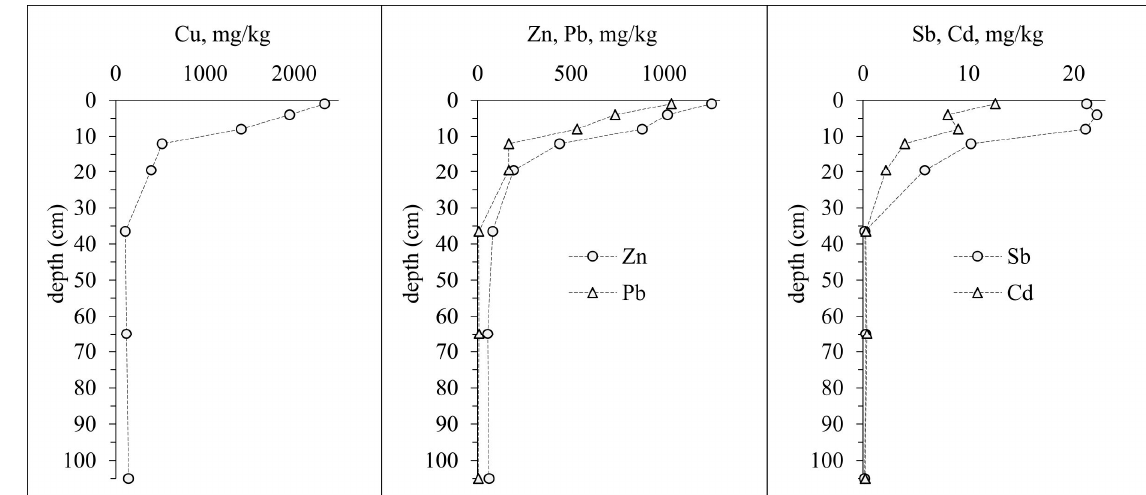
Figure 2. The view of Karabashskiy Copper-Smelting Plant (photo by the author).